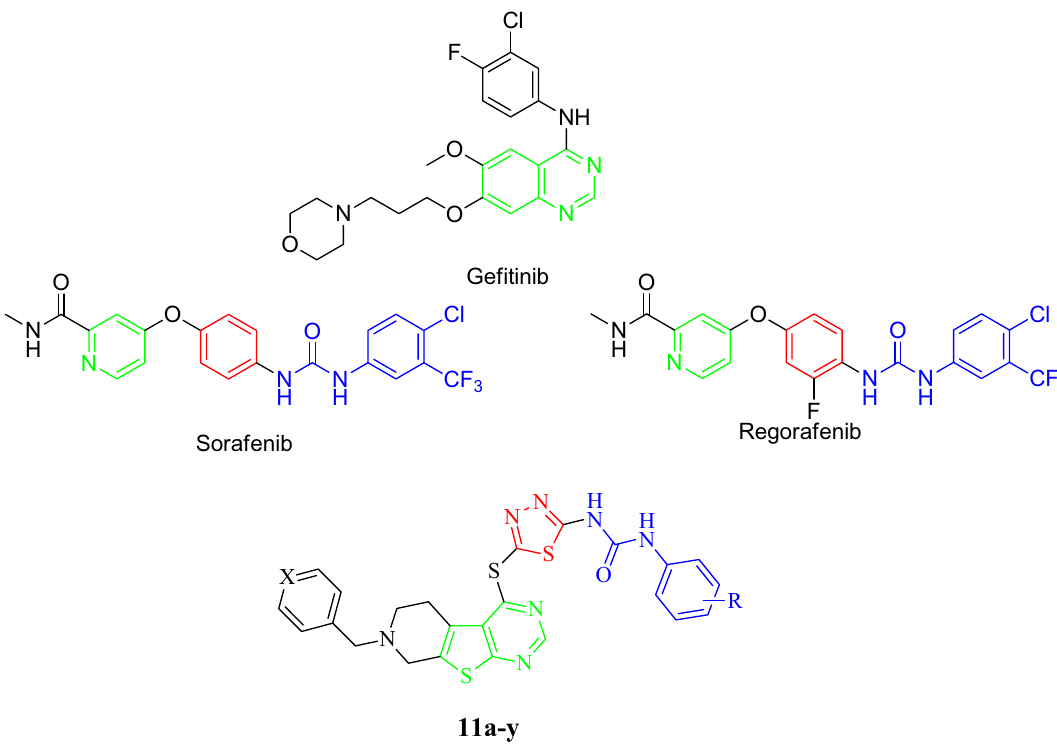
Figure 1. Structure-based design of the target compounds by structural modification of VEGFR-2